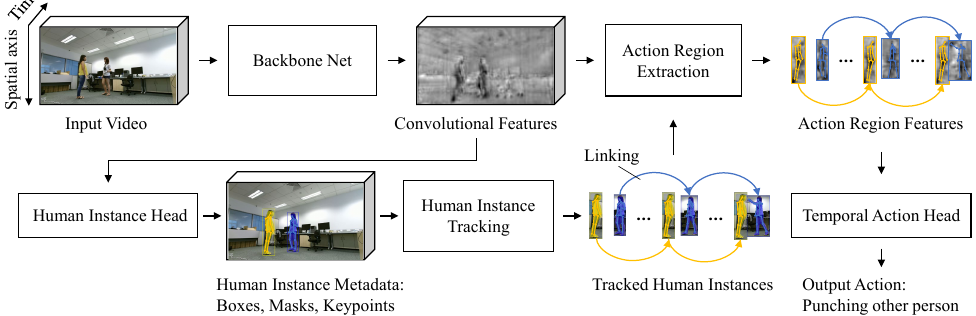
Figure 1. The proposed human instance-guided video action recognition framework. In the backbone network, the human instance head network is spatially done for each image in the video. Human instance tracking, action region extraction, and the temporal action head network are temporally performed for the entire video